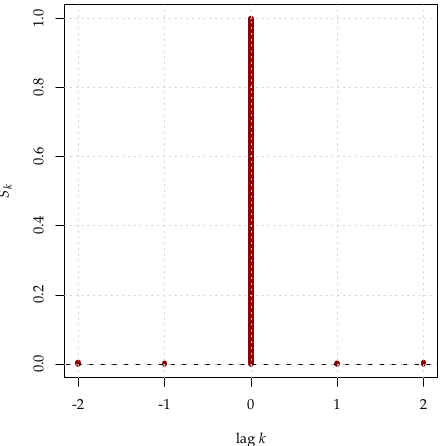
Figure 5. The same as Figure 4 (right) but with plot